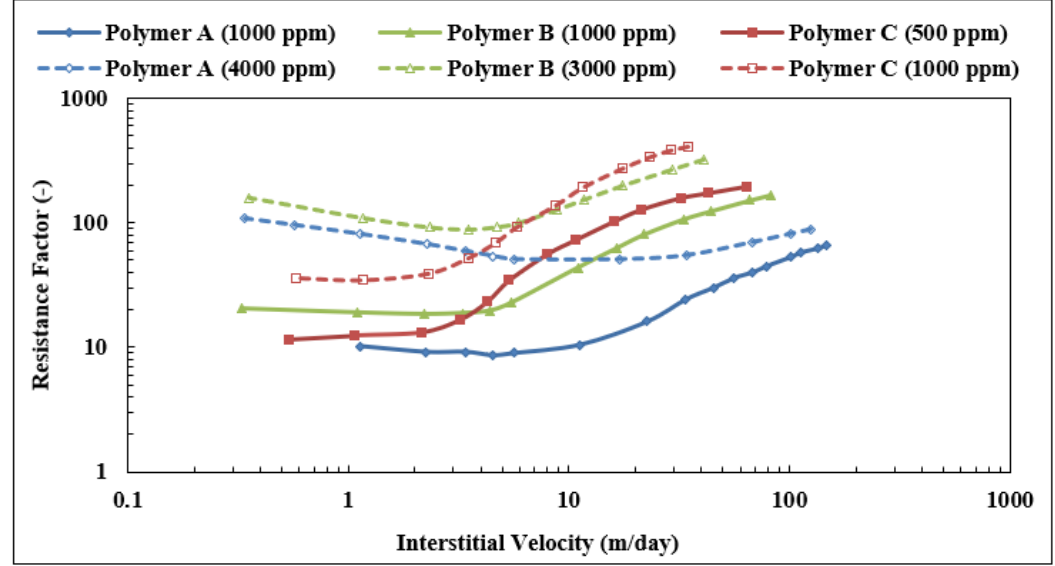
Figure 8. Resistance factor versus interstitial velocity for prefiltered polymers A, B and C at different concentrations.